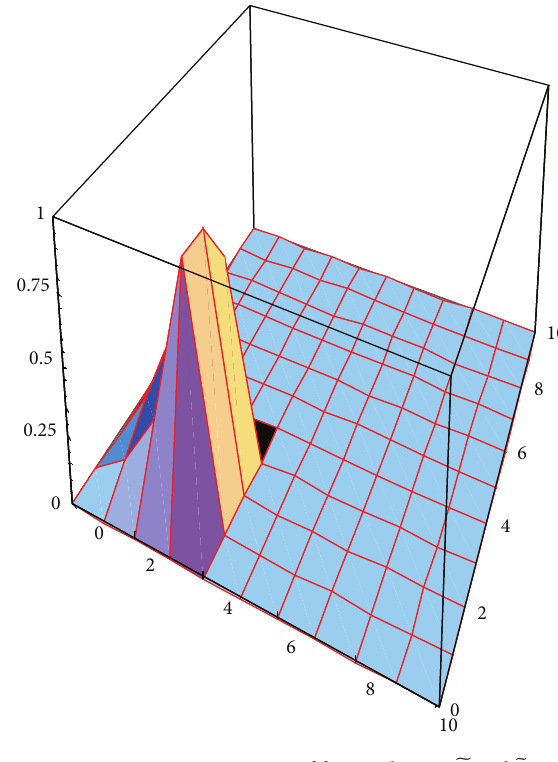
Figure 13: Demonic union of fuzzy relations